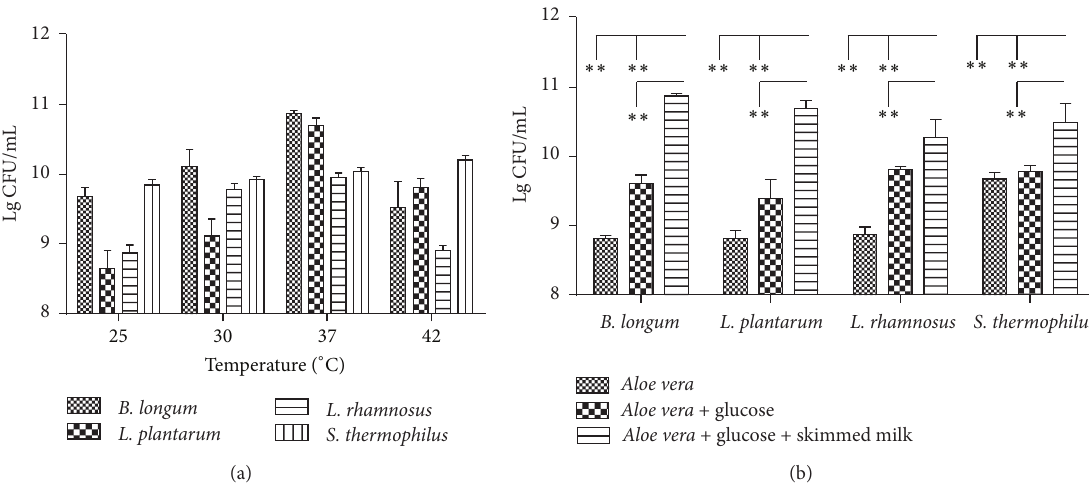
Figure 1: The suitable temperature (a) and fermentation substrates (b) for B. longum , L. plantarum , L. rhamnosus GG, and S. thermophilus . The significant analysis was done between Aloe vera , Aloe vera + glucose, and Aloe vera + glucose + skimmed milk. Data are shown as the mean ± SD. ∗∗ 𝑃 < 0.01